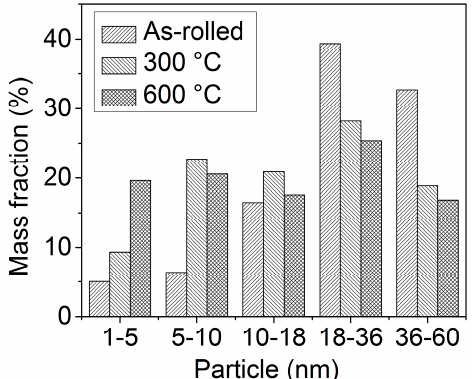
Figure 8. The diameter distribution plot of (Nb, V, Mo)C